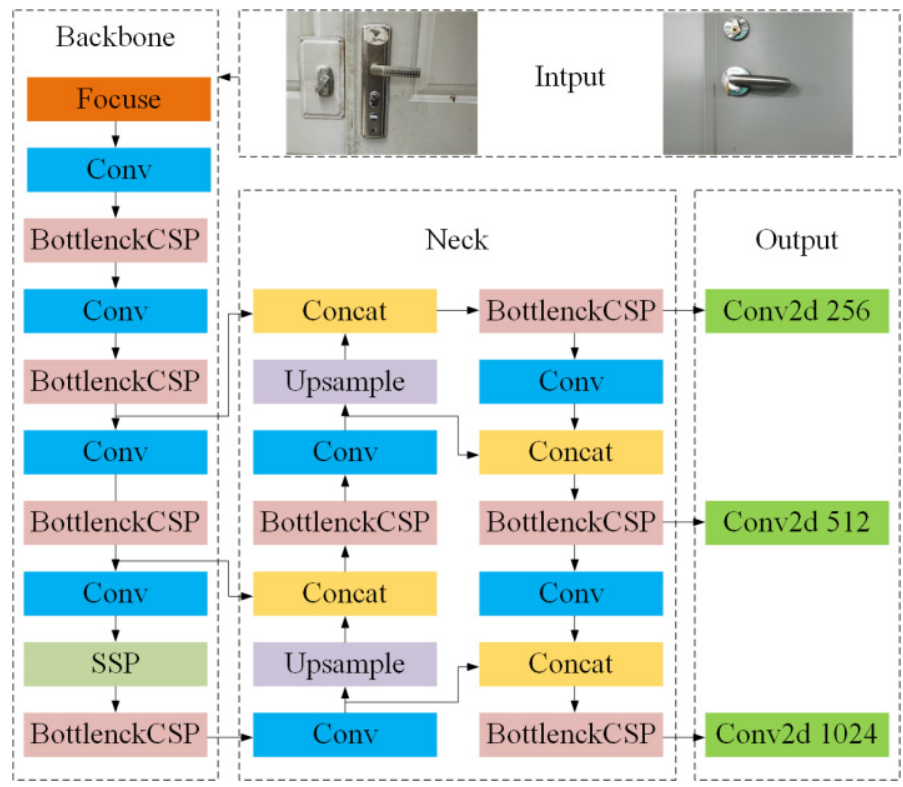
Figure 1. The structure diagram of the YOLOv5 model. The input terminal Input adopts a data-enhancement method to perform an adaptive scaling operation on the input image. The focus structure at the front end of Backbone effectively improves the quality of image extraction through convolution operations. The center and scale prediction (CSP) structure enhances the network’s ability to fuse features. The spatial pyramid pooling (SPP) module first uses kernels of varied sizes to perform max-pooling operations. Neck aggregates the feature information with the output